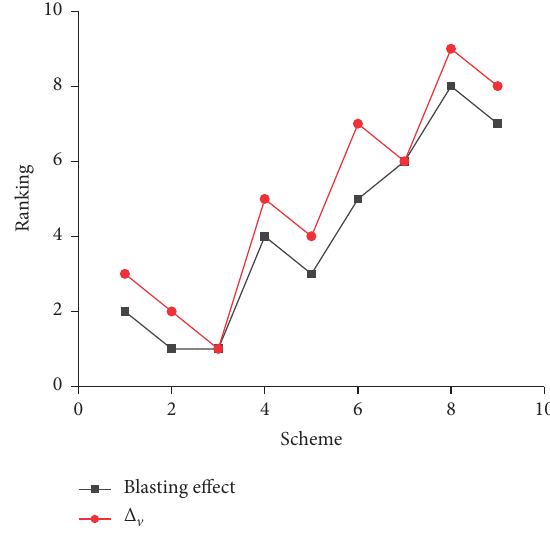
Figure 7: Δ V ranking and blasting effect ranking.